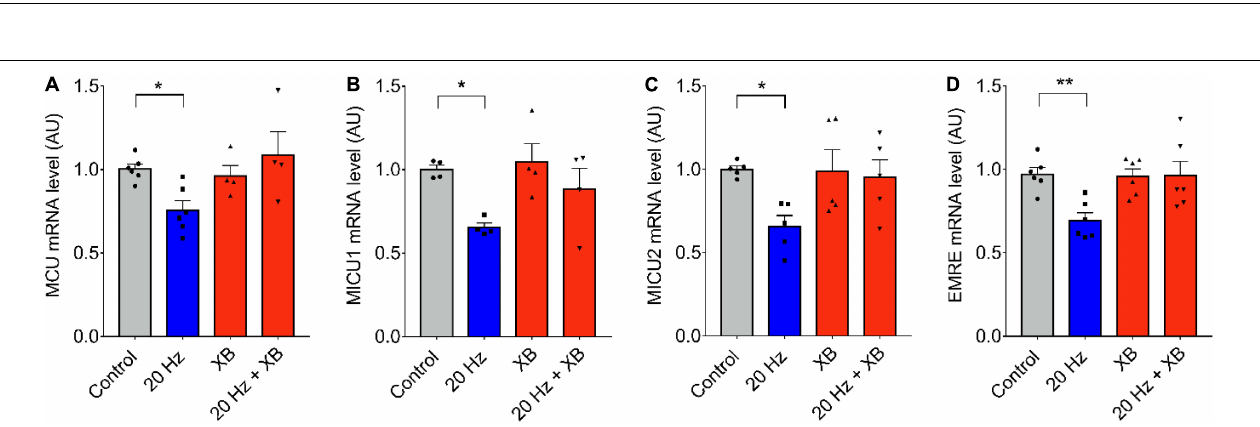
FIGURE 3 | Extracellular ATP is sufficient to reduce mRNA levels of the MCU complex in skeletal muscle fibers. Muscle fibers fdb muscle and stimulated with exogenous ATP (30 µ M). A decrease in mRNA levels of all the MCU complex components after 30 min of stimulation is observed. mRNA levels are shown normalized by mRNA level of control fibers. mRNA levels for MCU ( n = 4–14) (A) , MICU1 ( n = 8) (B) , MICU2 ( n = 8) (C) , and EMRE ( n = 5) (D) were measured. Values are presented as mean ± SEM. 18S was used as normalizer. * p < 0.05; ** p < 0.01; *** p < 0.001.